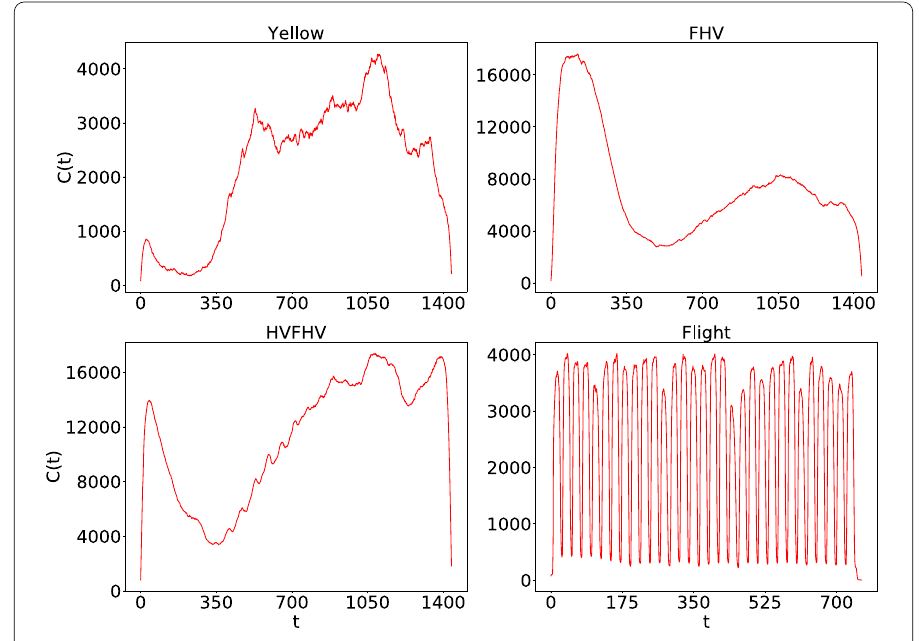
Figure 3 CSS distribution of the real-world networks used in the